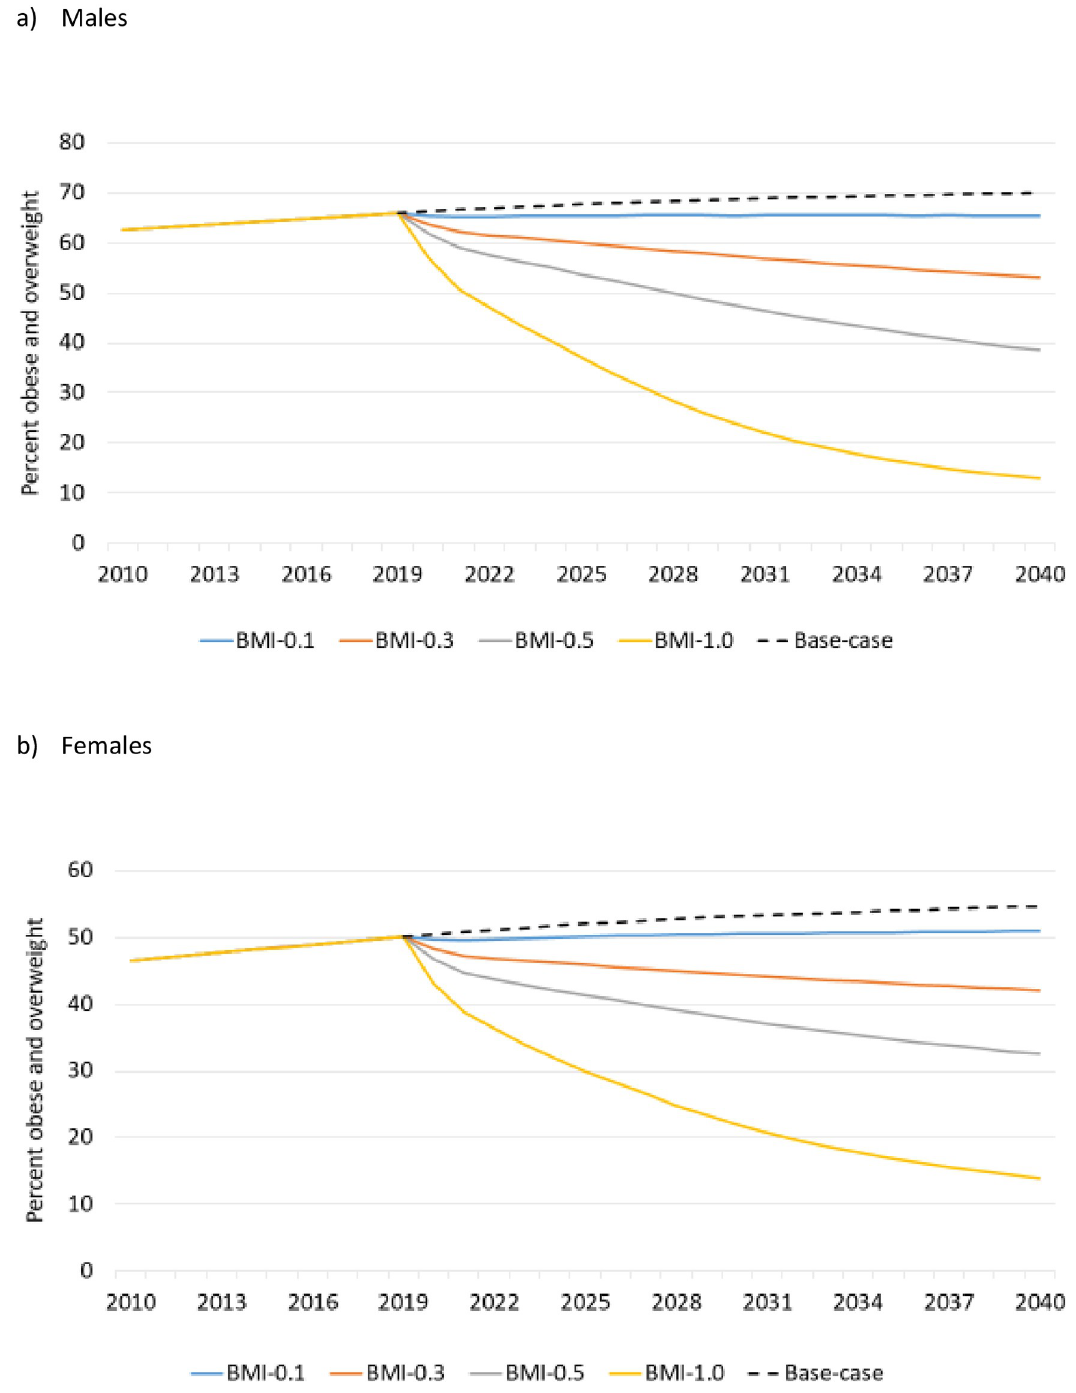
Fig 3. Percentage obese and overweight in the population under four preventive intervention scenarios. All interventions are described in Table 1.